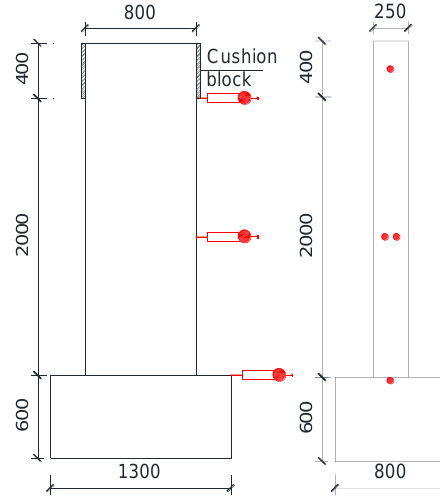
Figure 4. The Layout of Displacement Gauges.